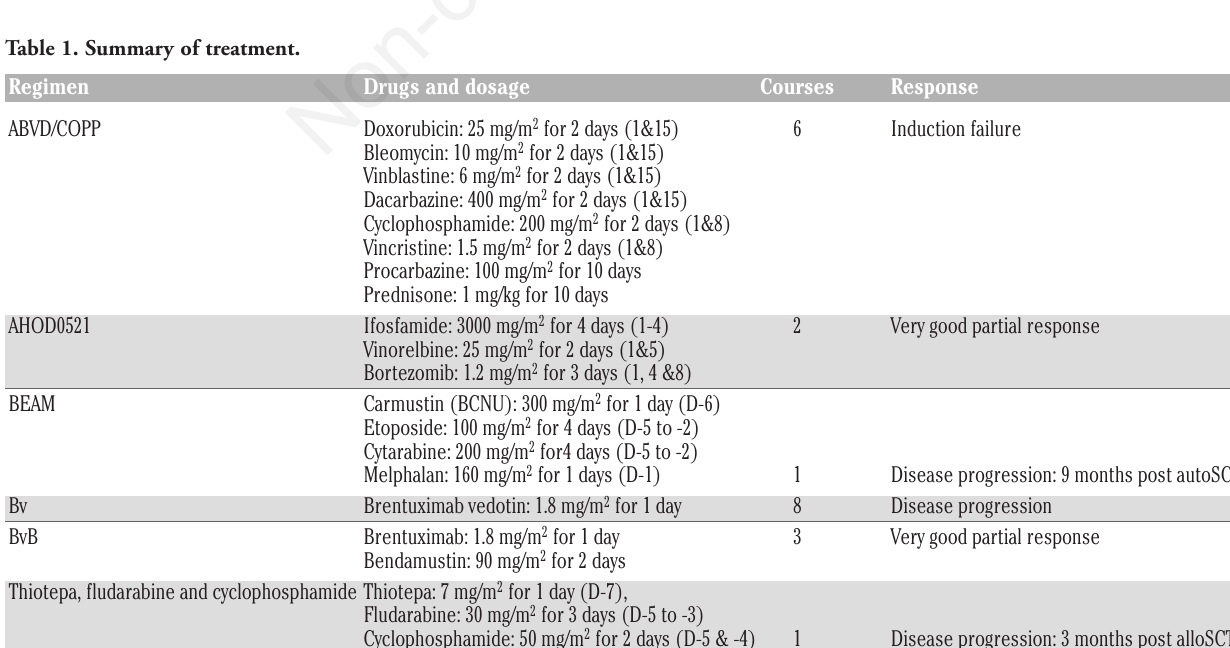
Table 1. Summary of